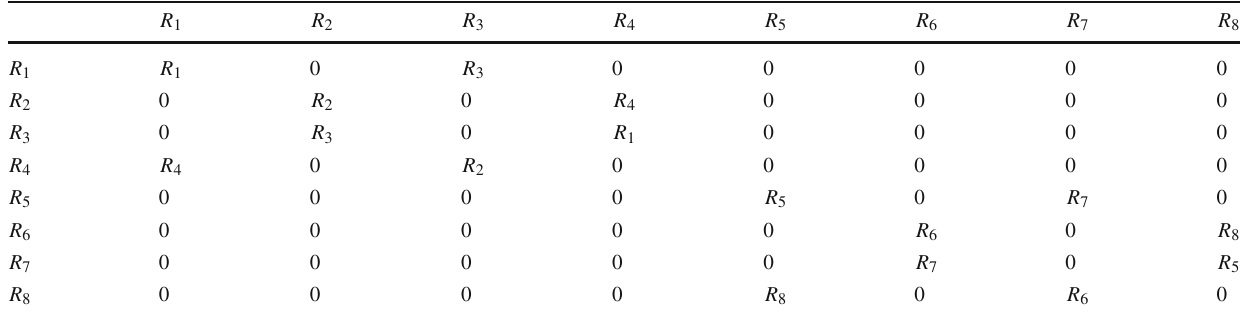
Table 1 Multiplicative properties of the matrix basis